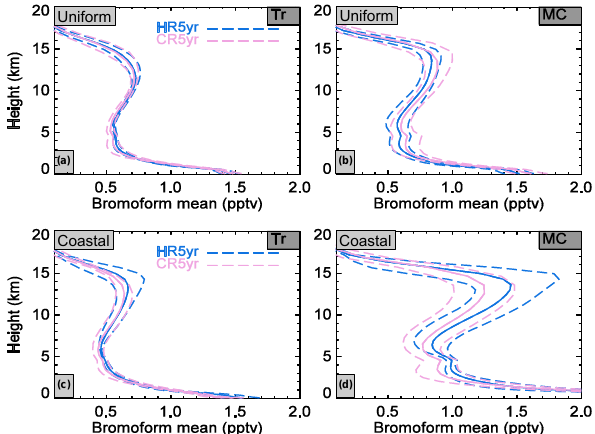
Figure 6. Average vertical profiles of the mixing ratios for the Uni- form tracer in five representative Februaries (1996, 1998, 2000, 2002, 2005) are shown for (a) the Tropics (20 ◦ S–20 ◦ N) and (b) the Maritime Continent (20 ◦ S–10 ◦ N; 90–160 ◦ E). Equivalent plots for the Coastal tracer are shown in (c) and (d) . High-resolution run is shown in blue; the coarse-resolution run is shown in pink. Dashed lines indicate 2 standard deviations from the mean